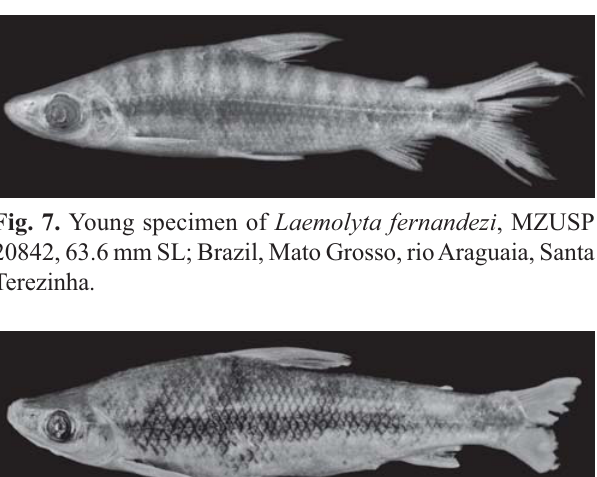
Fig. 10. Geographic distribution of Laemolyta taeniata (black dots; open circle = type-locality) and of Laemolyta fernandezi (black squares; open squares = type-locality).